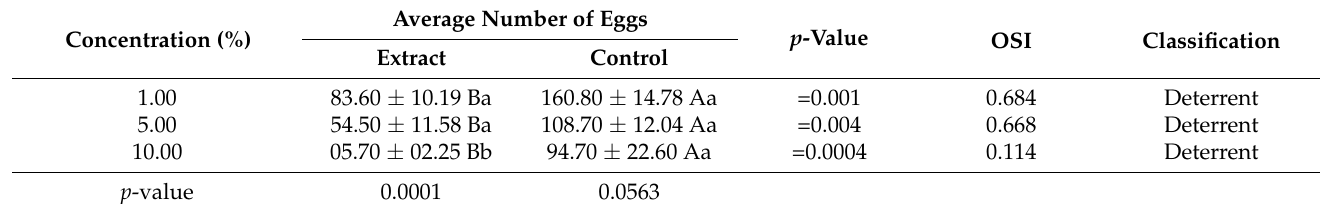
Table 5. Oviposition suppression index (OSI) of Plutella xylostella according to the number of eggs deposited on discs treated with distilled water (control) and with botanical extracts of Miconia albicans .